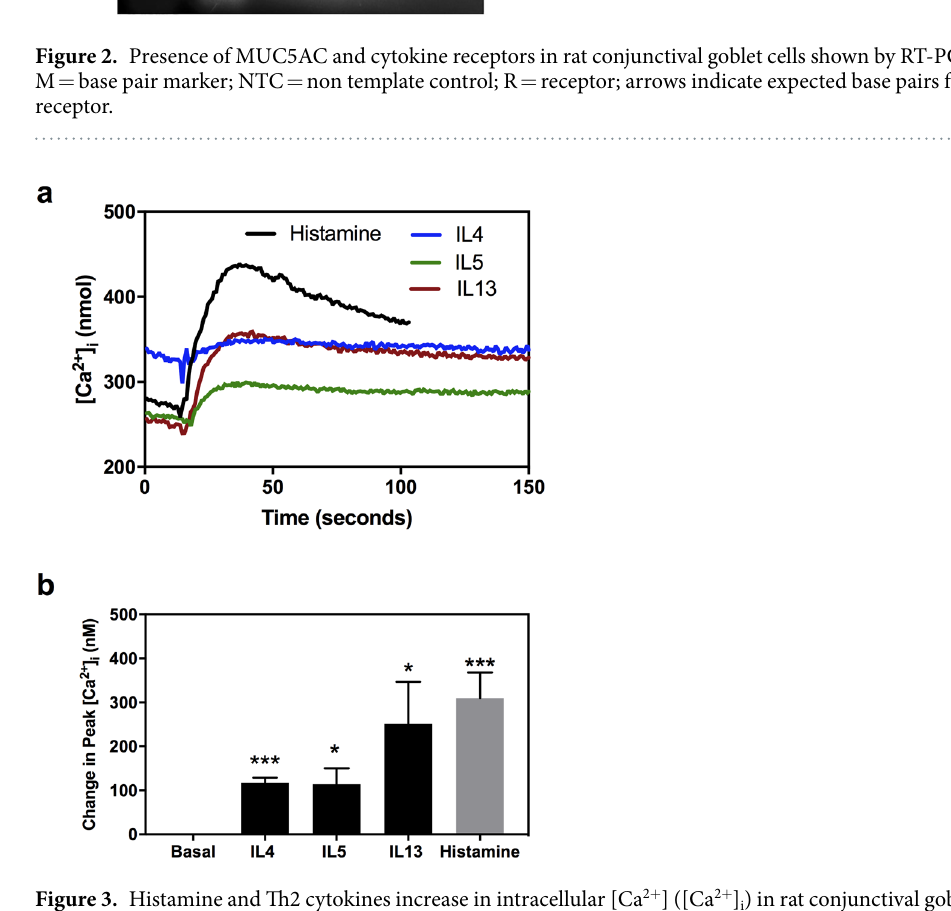
Figure 3. Histamine and Th2 cytokines increase in intracellular [Ca 2 + ] ([Ca 2 + ] i ) in rat conjunctival goblet cells. ( a ) Mean [Ca 2 + ] i over time after addition of 10 − 5 M histamine, 10 ng/ml IL4, 10 ng/ml IL5, or 10 ng/ml IL13. ( b ) Peak value over basal in response to histamine, IL4, IL5 or IL13. Data are expressed as mean ± SEM of four independent experiments. * indicates statistical significance compared to basal values. * p ≤ 0.05; *** p ≤